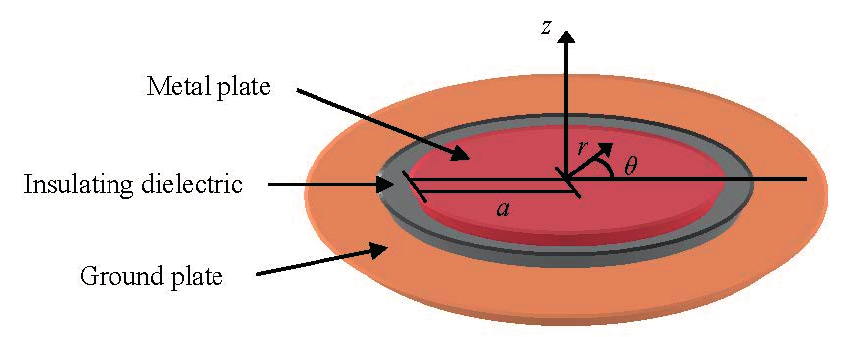
Figure 4. Resonant disc structure for UHF patch